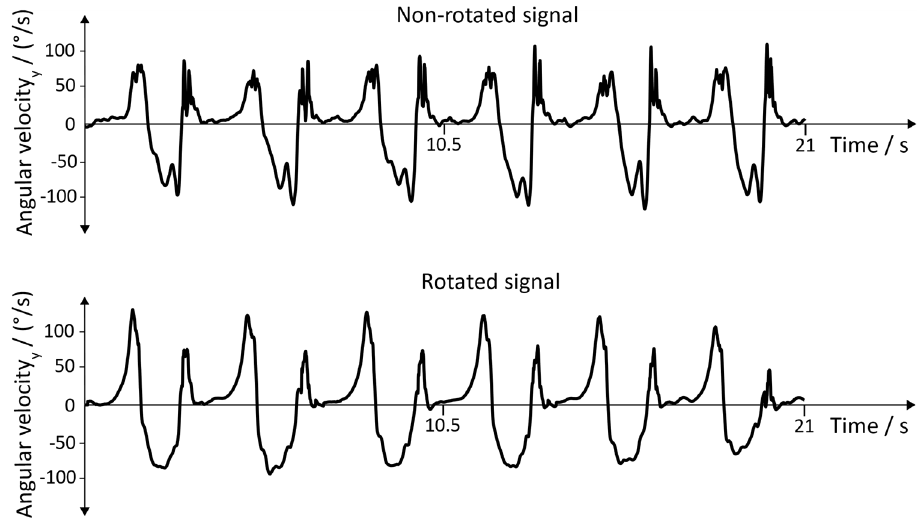
Figure 16. Non-rotated signal and rotated signal of the y(cid:4652)⃗ (cid:2911)(cid:2934)(cid:2919)(cid:2929) . Position of the sensor: dorsum of the foot.